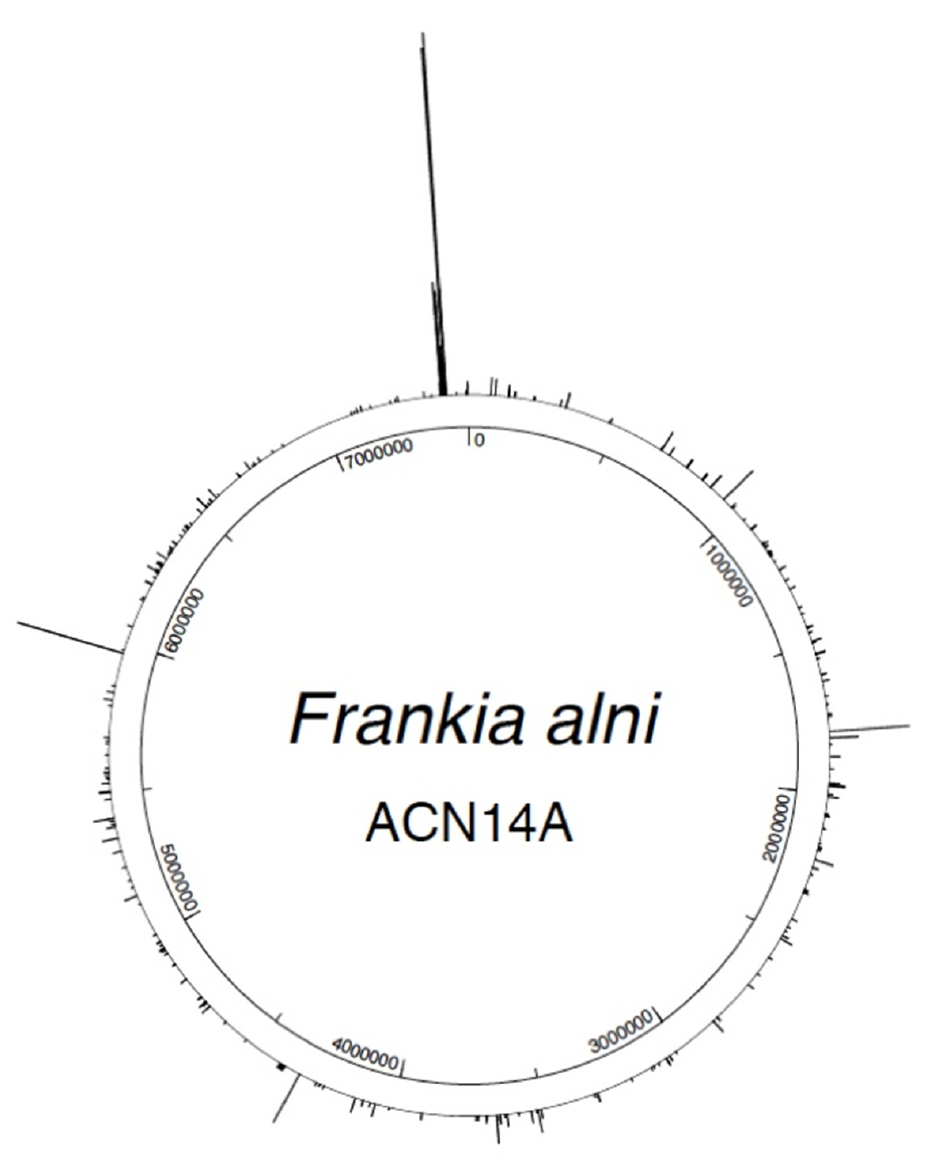
Figure 1. Circular map of the genome of Frankia alni with the proteins over-abundant in nodules relative to a nitrogen-replete pure-culture (FC ≥ 2) positioned along the genome. The nif genes are at the top close to the origin of replication.